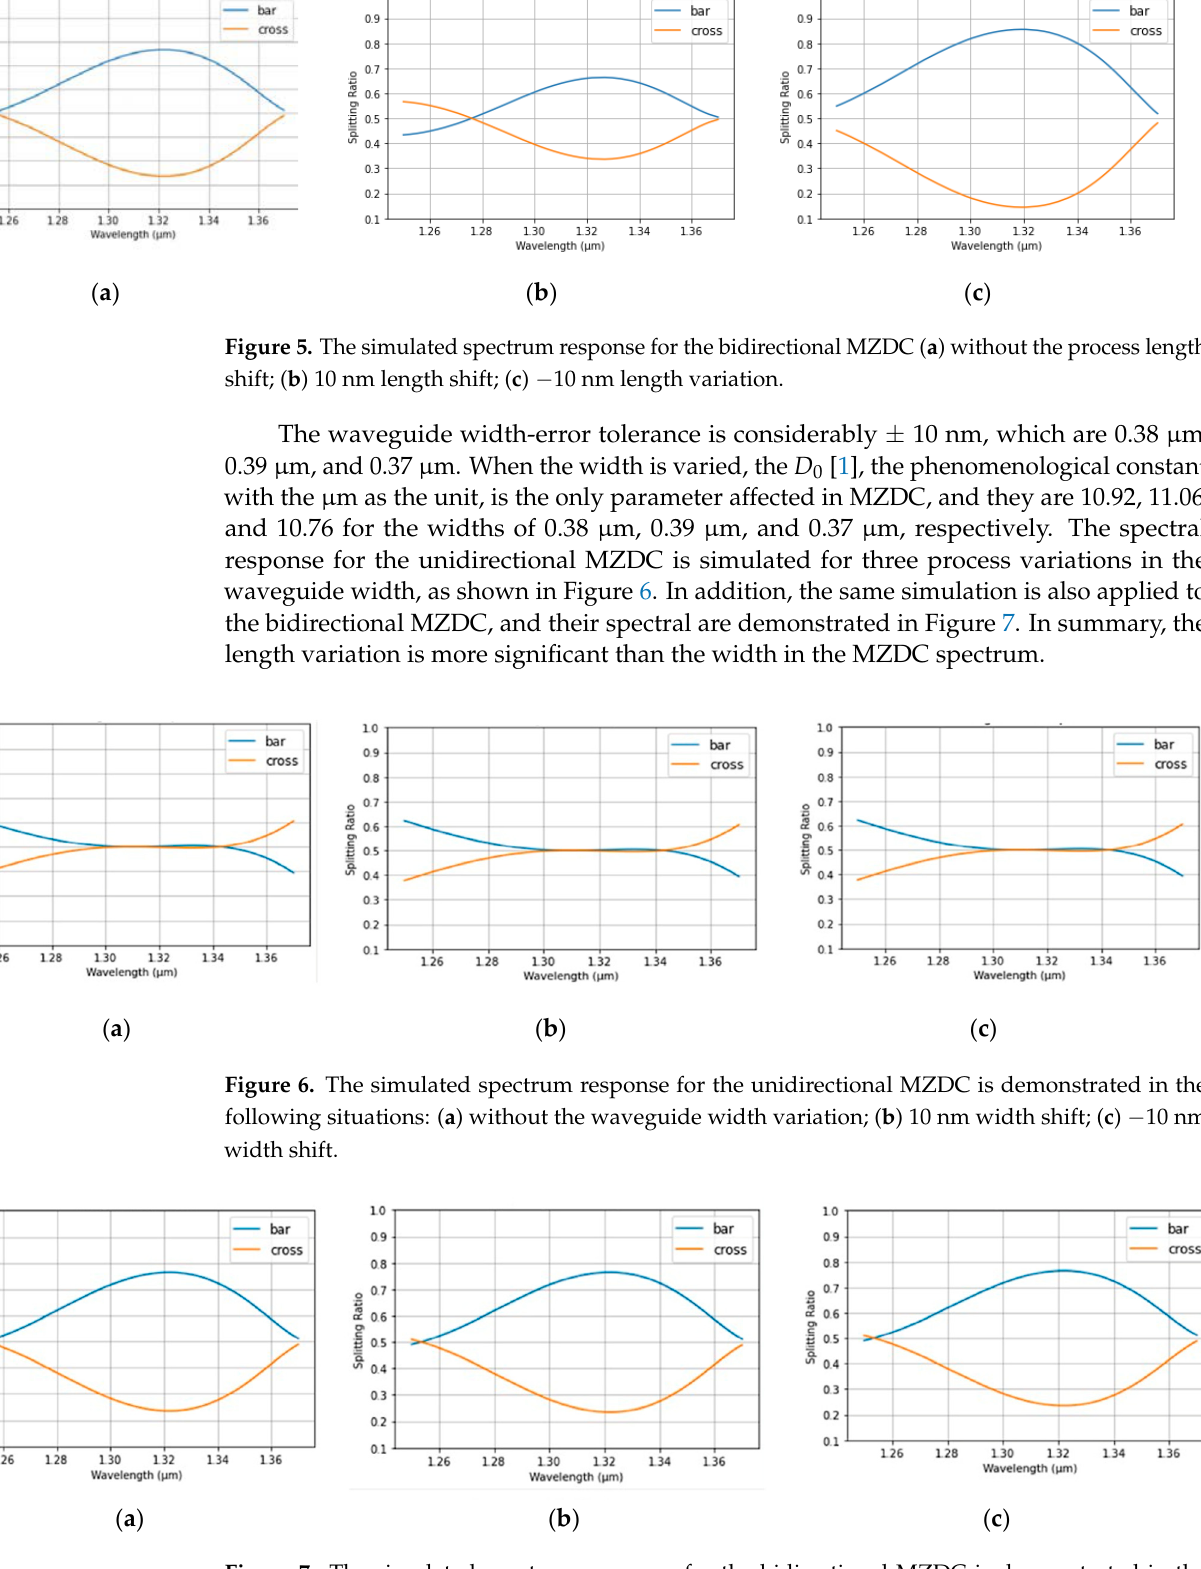
Figure 7. The simulated spectrum response for the bidirectional MZDC is demonstrated in the following situations: ( a ) without the waveguide width variation; ( b ) 10 nm width shift; ( c ) − 10 nm width shift.